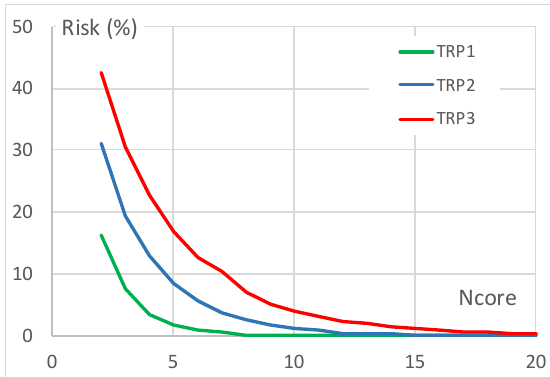
Figure 4. Indicative relation between the risk value, TRP and number of cores (warning: these curves correspond to a specific concrete and cannot be taken at face